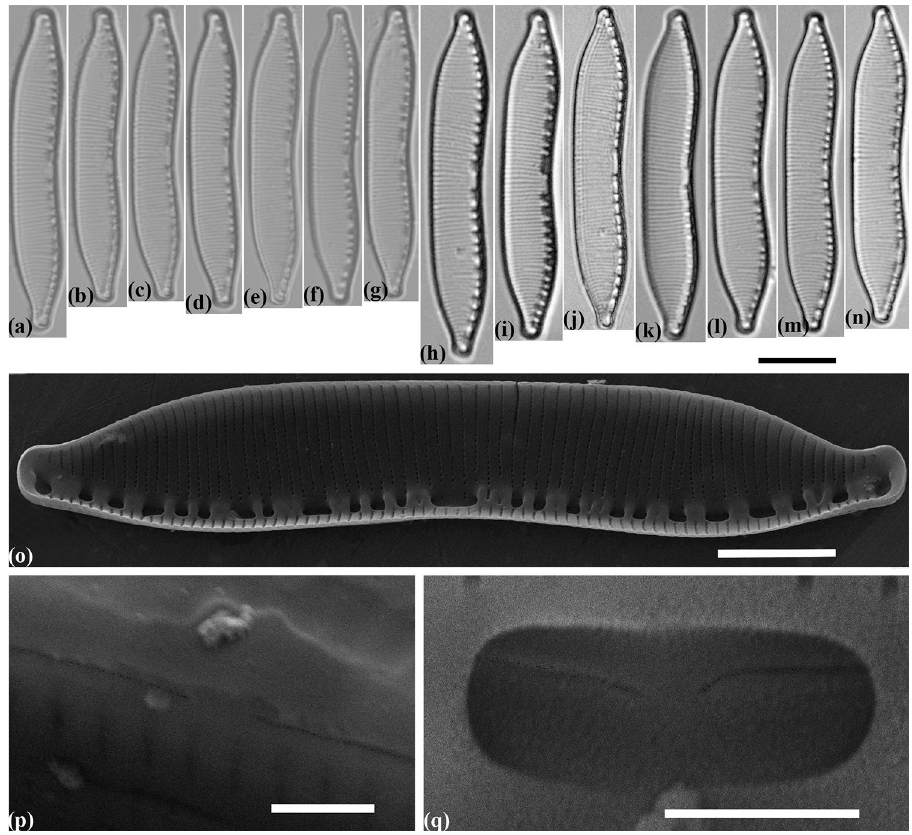
Figure 6. Valve morphology of representatives from the different strains Hantzschia parva . ( a – n ) Light micrographs. ( a – c ) Natural population of H. parva MZ–BH4. ( d – g ) Monoculture of H. parva MZ–BH4. ( h – j ) Natural population of H. parva MZ–BH3. ( k – n ) Monoculture of H. parva MZ–BH3. ( o ) Scanning electron micrographs of H. parva MZ–BH4, interior of valve. ( p ) Scanning electron micrograph of H. parva MZ–BH4, exterior of valve at valve center, showing almost straight the central raphe endings. ( q ) Scanning electron micrograph of H. parva MZ–BH3, interior of valve at valve center, showing the unilateral bent of the central raphe endings. Scale bars ( a – n ) = 10 µm, ( o ) = 5 µm, ( p , q ) = 1